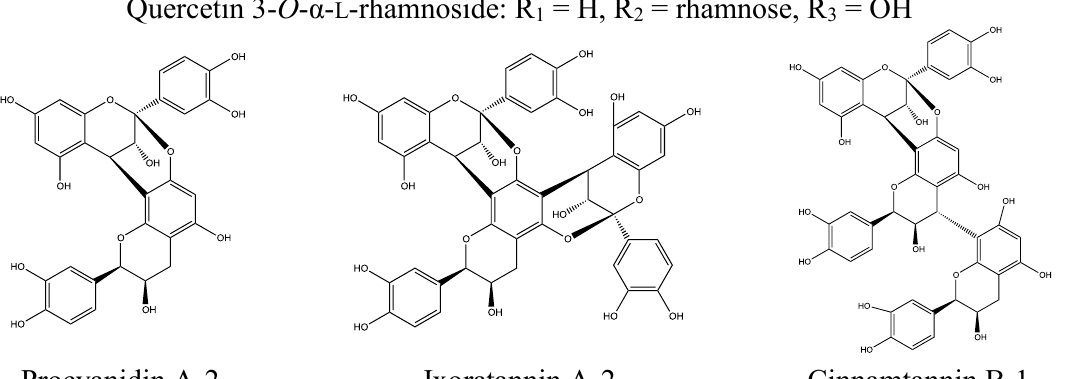
Kaempferol 3- O -α- L -rhamnoside: R Kaempferol 7- O -α- L -rhamnoside: R Kaempferol 3,7-di-α- L -rhamnoside: R Quercetin 3- O -α- L -rhamnoside: R